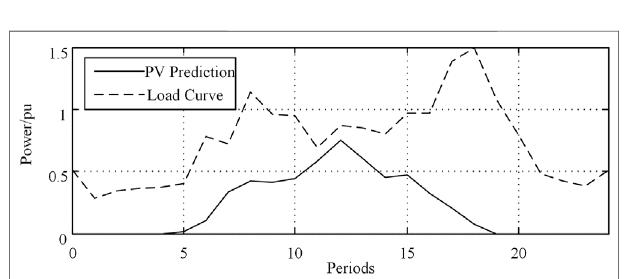
FIGURE 8 | PV prediction power curve and load curve.